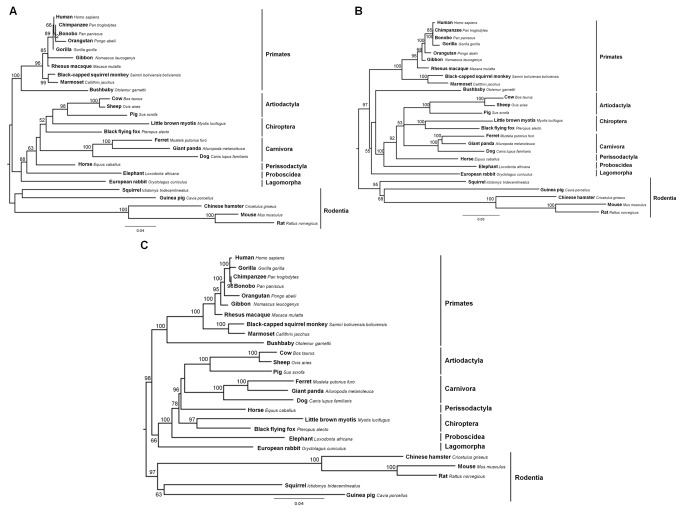
Maximum likelihood (ML) phylogenetic trees of mammalian MDA5 gene used for codon-based ML analysis.When testing mammalian MDA5 alignment for recombination, one significant breakpoint was detected at nucleotide position 903. (A) A phylogenetic tree was reconstructed for the first 903 nucleotides under the nucleotide substitution model TIM3+G. (B) A second ML tree was inferred for the remaining 2211 nucleotides and under the nucleotide substitution model TIM3+I+G. (C) A tree was also reconstructed for MDA5 total alignment without recombination testing and under the nucleotide substitution model GTR+G. Bootstrap values >50 are indicated on the branches.